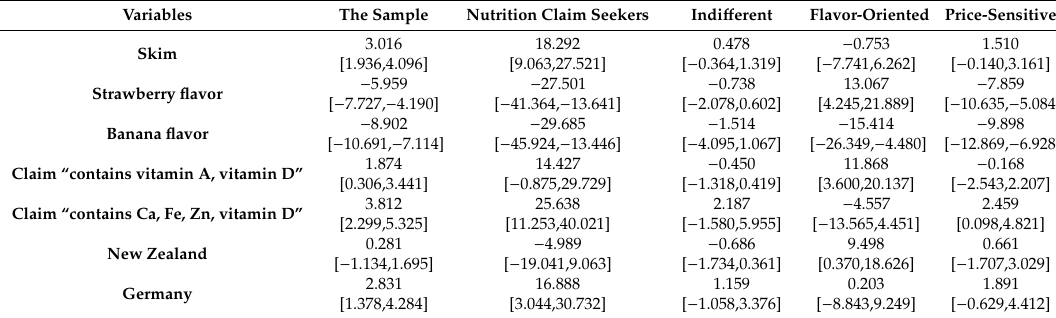
Table 5. Consumer WTP for each level (yuan / 200